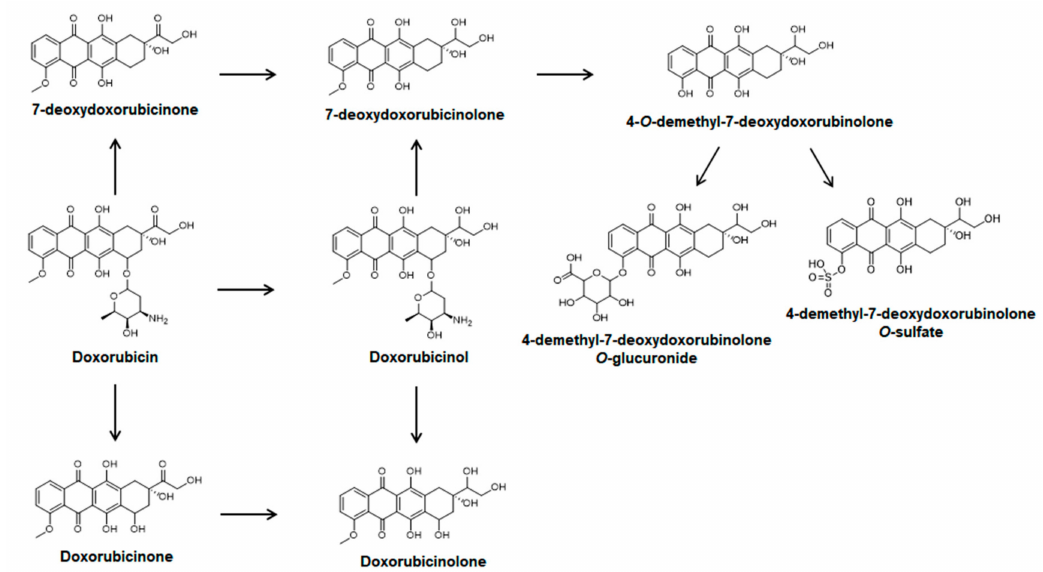
Figure 1. Metabolic pathways of